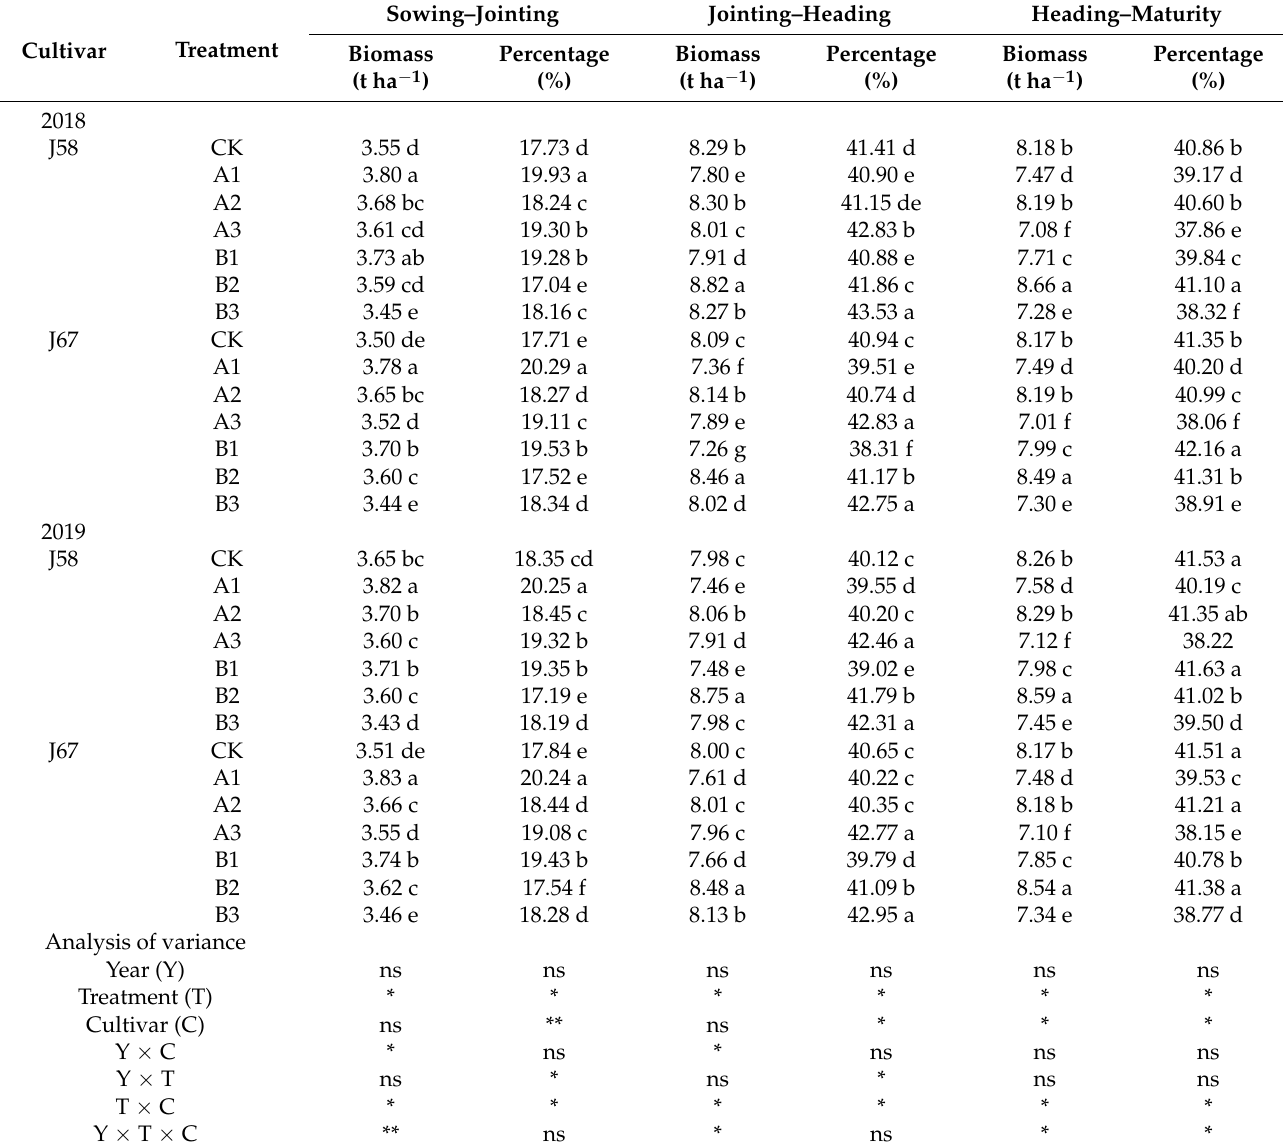
Table 3. Differences in the amounts and percentages of above-ground biomass accumulation of japonica rice.